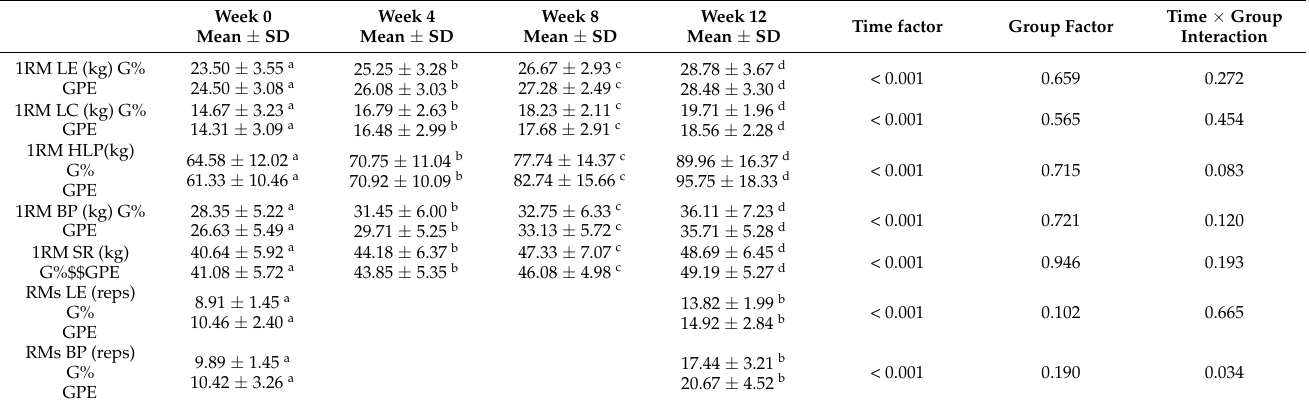
Table 4. Mean and standard deviation (SD) for maximal dynamic strength tests (1RM; kg) and muscular endurance test (RMs; rps) for the different exercises (LE = leg extension; LC = leg curl; HLP = horizontal leg press; BP = bench press, SR = seated row) for each training group (G% and GPE), over training program (weeks 0, 4, 8, and